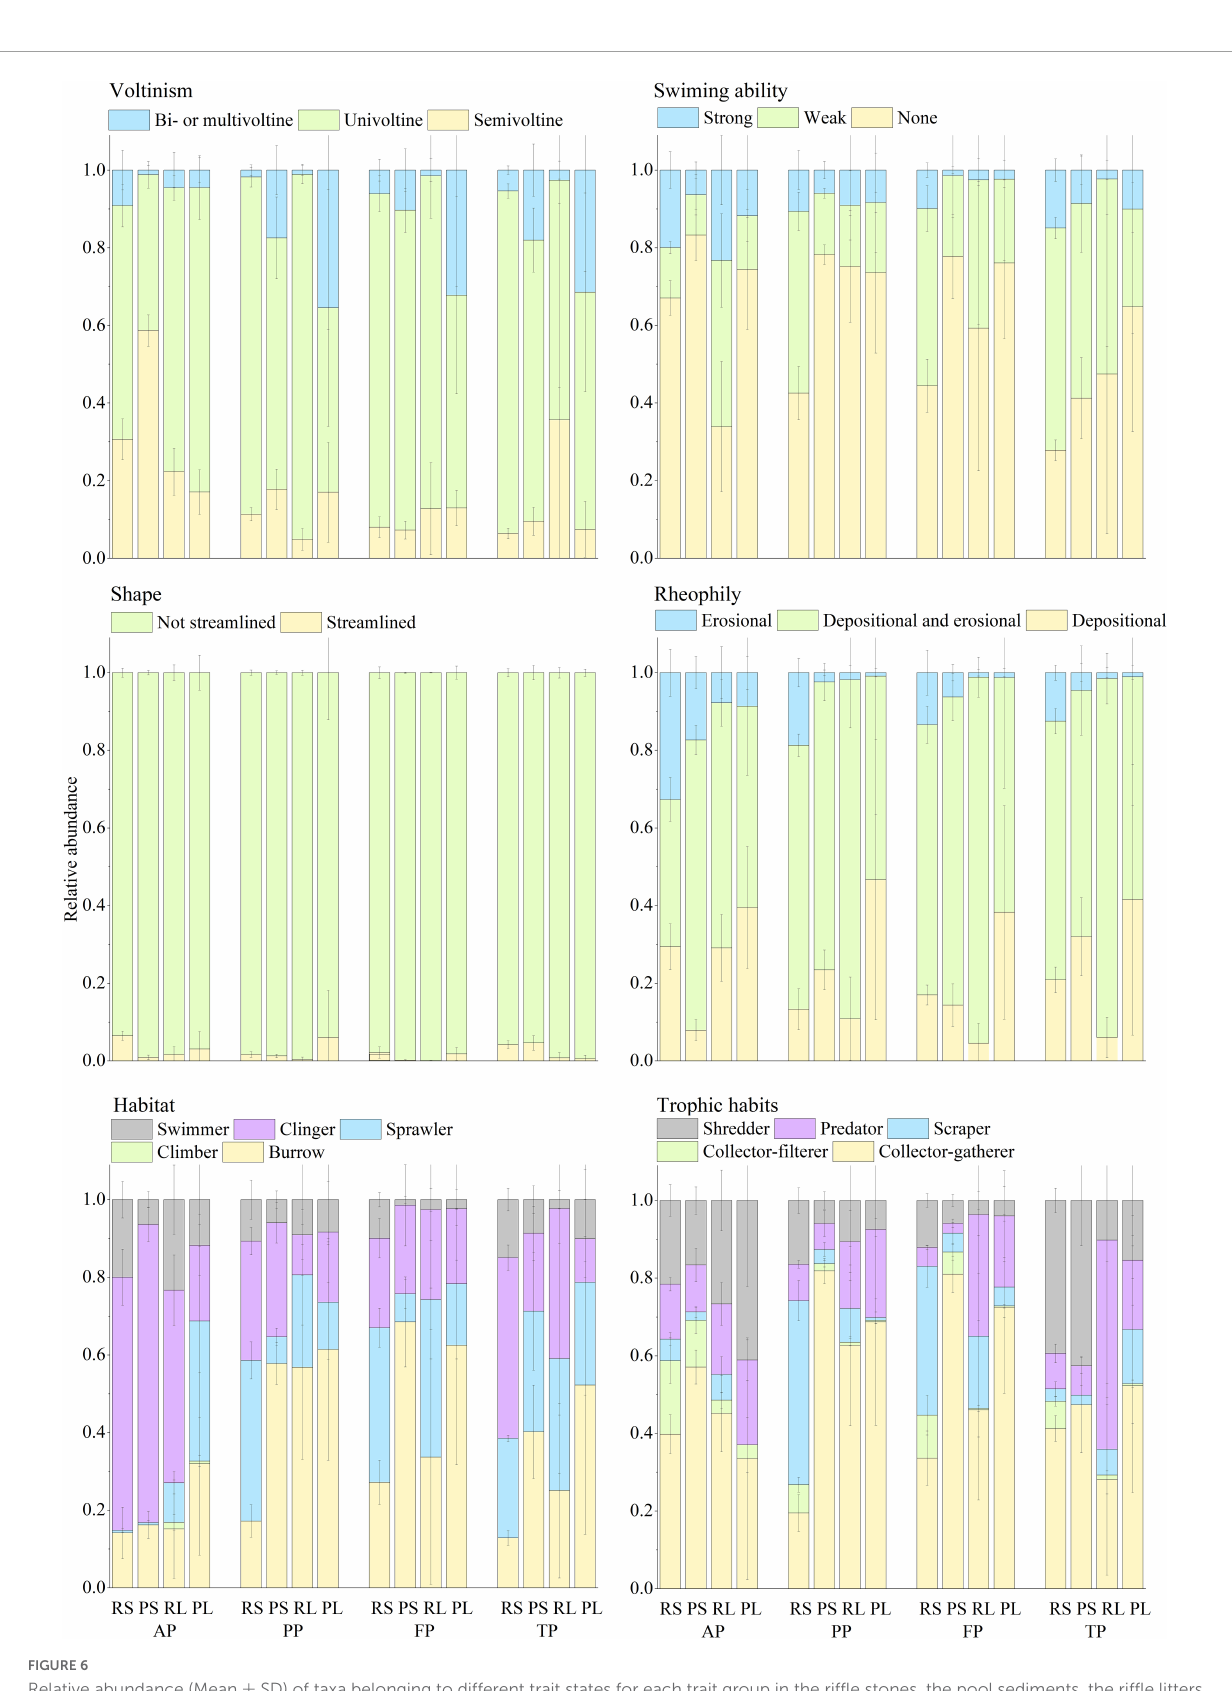
FIGURE6 Relative abundance (Mean ± SD) of taxa belonging to different trait states for each trait group in the riffle stones, the pool sediments, the riffle litters, and the pool litters during different period. RS, riffle stones; PS, pool sediments; RL, riffle litters; PL, pool litters; AP, the autumn period; PP, the pre-freezing period; FP, the freezing period; TP, the thawing